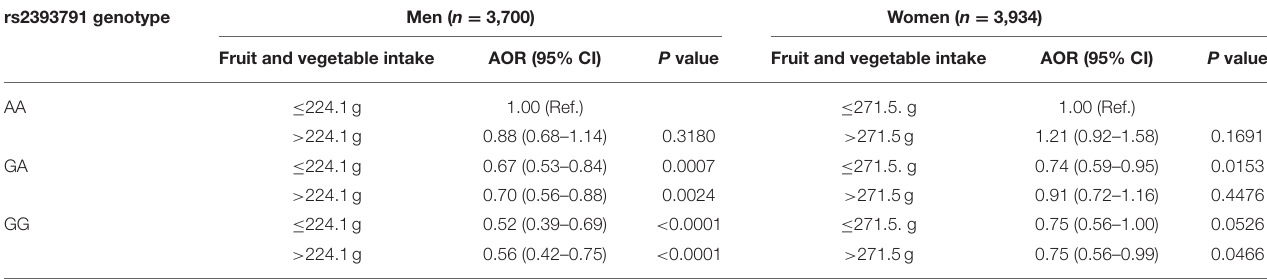
TABLE 6 | Association of HNF1A rs2393791 genotype and total fruit and vegetable intake with inflammation. rs2393791